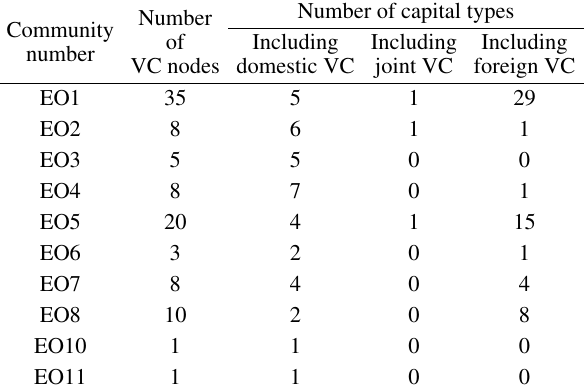
Table 7 Association of communities and capital types in EO detection of 42 VC industry leaders and 57VC companies that have invested with them on four or more times.